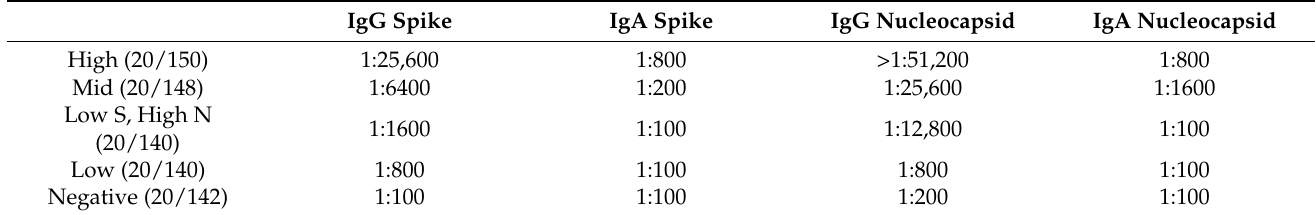
1:100 (Figure 3E,F). Correlations were consistently greater than R 2 of 0.90 when analysing the NAb data, except with undiluted plasma samples including the NIBSC negative when correlated with WHO values for NAb (R 2 = 0.88). Overall, the correlations observed were similar throughout, but tended to be stronger, such that greater R 2 values were seen when comparing PL-NAb data with anti-RBD antibody rather than NAb. These data suggest that the NAb test faithfully reproduces neutralisation data generated by PRNT with excellent sensitivity, and that anti-RBD antibodies in plasma are the likely neutralising component